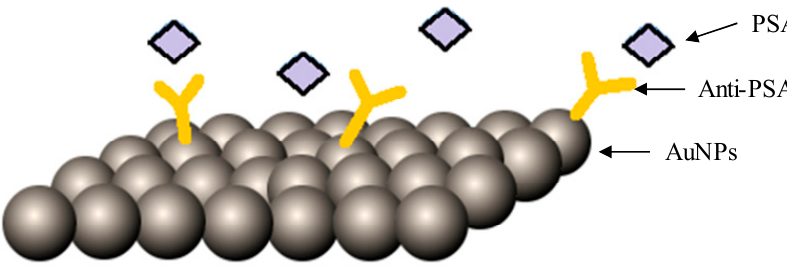
Figure 5. Representative image of 100 nm AuNPs (tethered to an electrode) coated with anti-prostate specific antigen (PSA) antibodies.